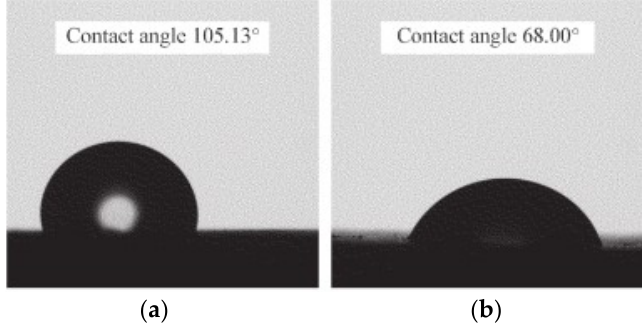
Figure 10. Effect of modification on distilled water wetting contact angle of rubber [54]. ( a ) Before modification. ( b ) After modification.